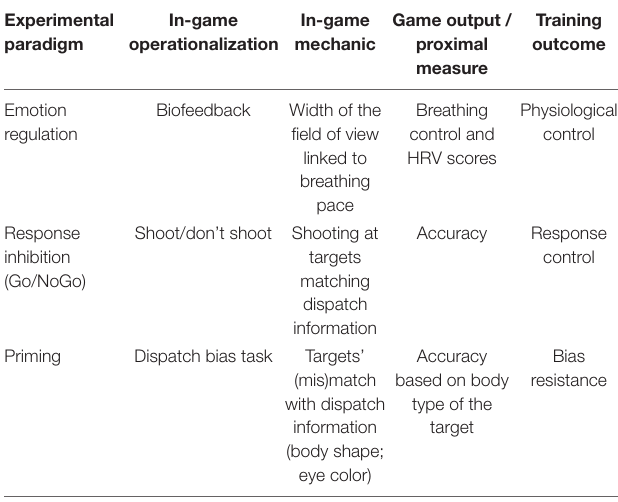
TABLE 1 | Operationalization of in-game tasks. Experimental